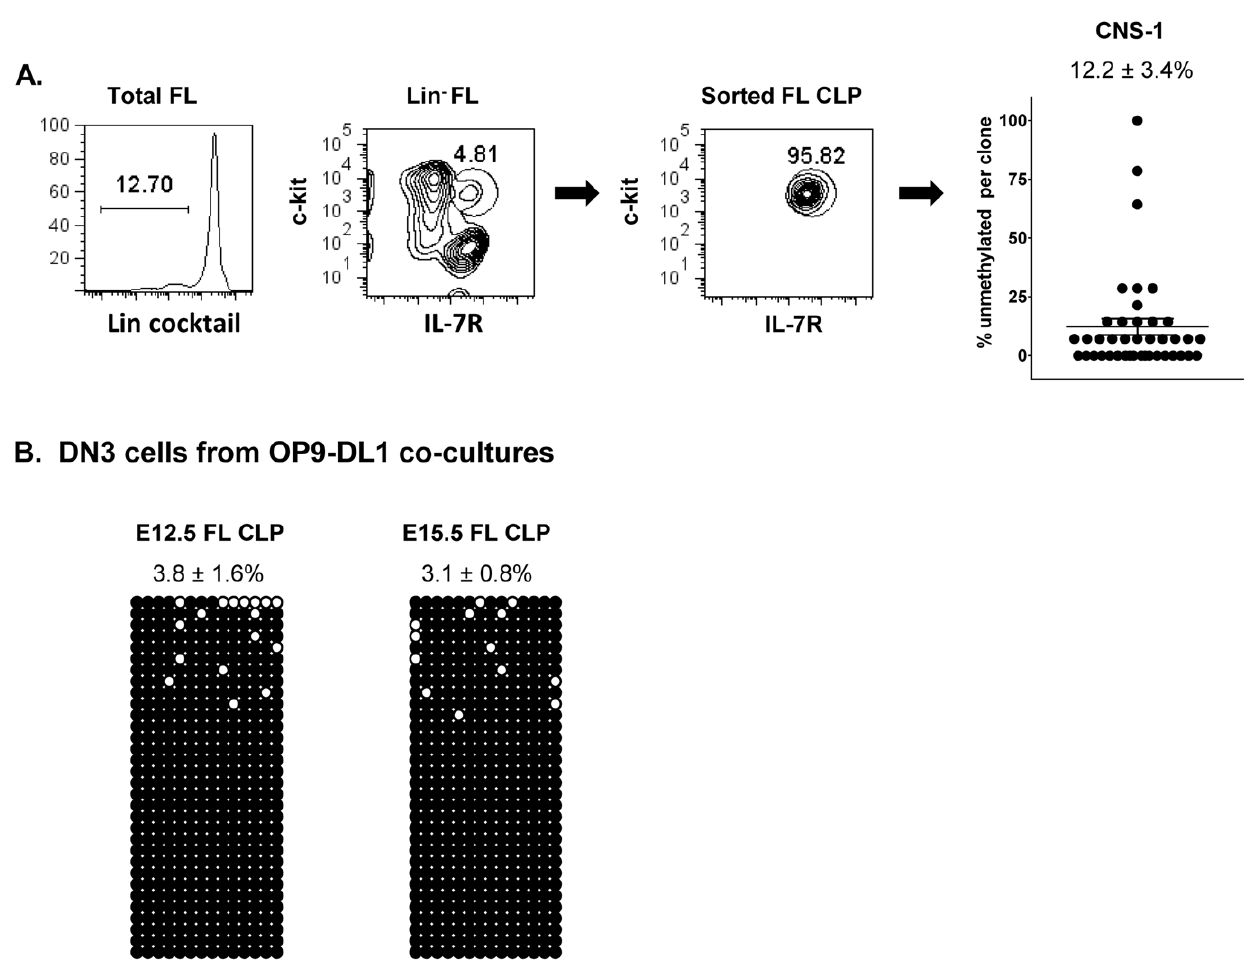
Figure 4. Fetal liver CLP-like cells and their progeny from OP9-DL1 cultures show Th2 locus hypermethylation. (A) CLP-like cells were isolated from C57BL/6 14 day fetal liver cells by sorting for lin - IL-7R + c-kit + cells and bisulfite sequencing analysis of CNS-1 was performed. Graphed are the conglomerate data from a total of 41 clones from 3 different cellular isolates. (B) DN3 progeny from OP9-DL1 cultures of: E 12.5 FL CLP-like cells (left panel): E 15.5 FL CLP-like cells (right panel). The data are derived from three independent CLP purifications and two culture set-ups.